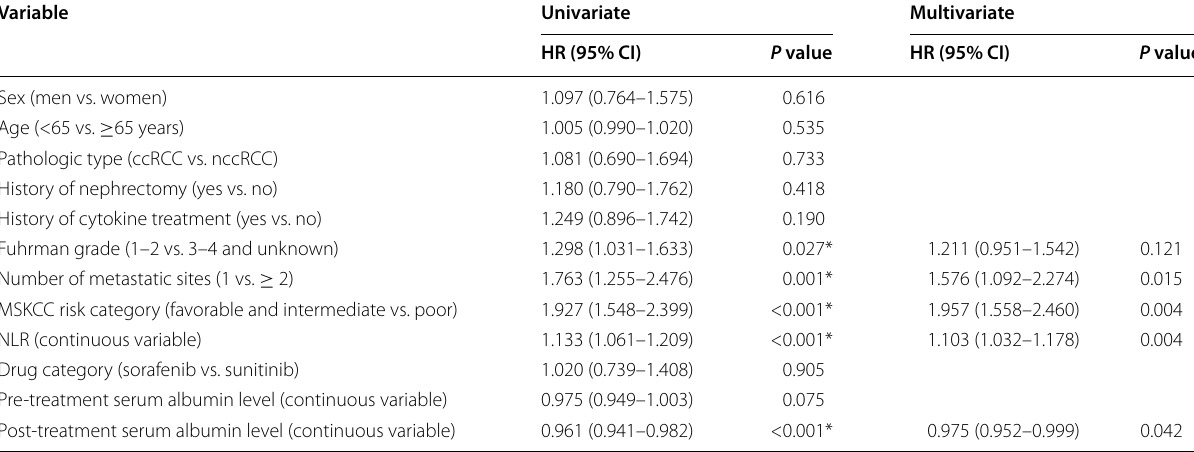
ccRCC, clear cell renal cell carcinoma; nccRCC, non-clear cell renal cell carcinoma; NLR, neutrophil-to-lymphocyte ratio; MSKCC, Memorial Sloan Kettering Cancer Center; HR, hazard ratio; CI, confidence interval * Variables with P values <0.05 in univariate analysis were considered for multivariate analysis